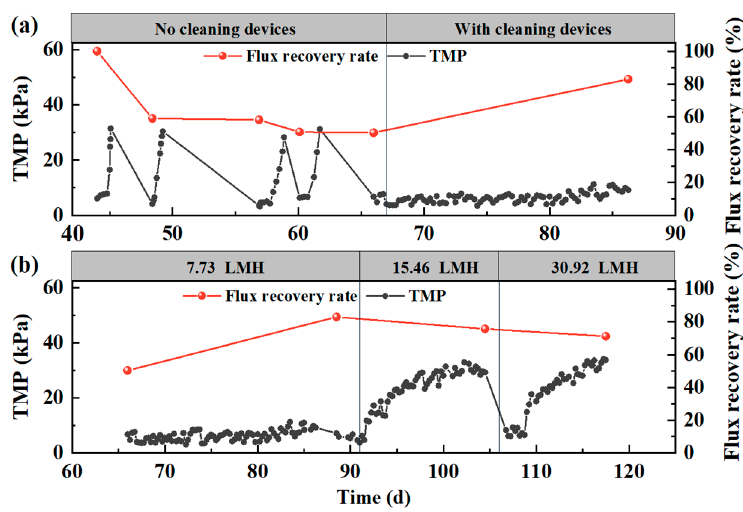
Figure 3. Impact of the fouling control on TMP and flux recovery: ( a ) initial flux at 7.73 LMH; ( b ) flux varied from 7.73 to 30.92 LMH.